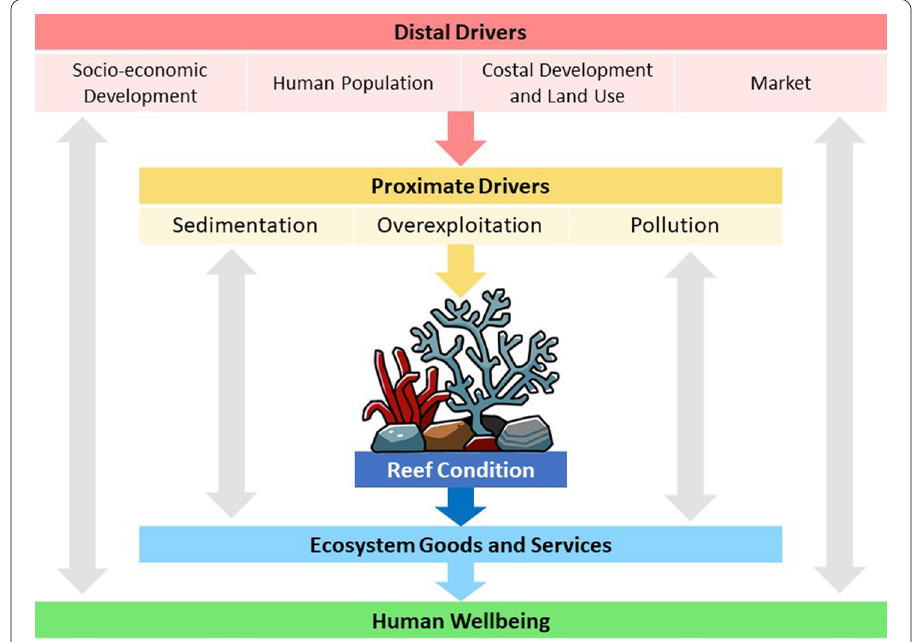
Fig. 1 The interrelationships and reciprocity between humans and coral